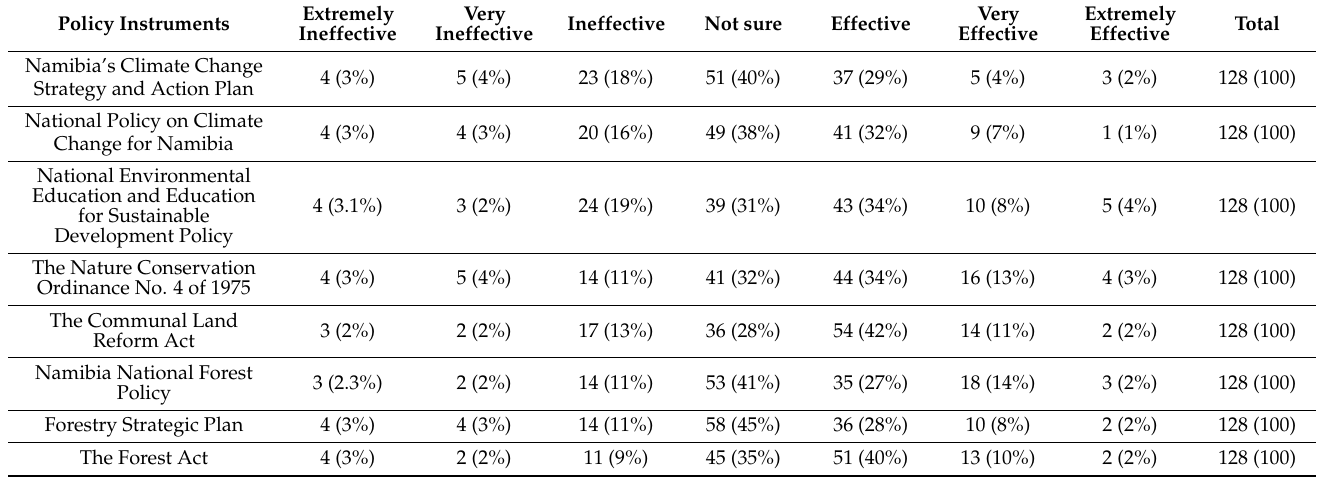
Table 2. The effectiveness of the policy instruments for climate change adaptation in mopane woodlands in northern Namibia.